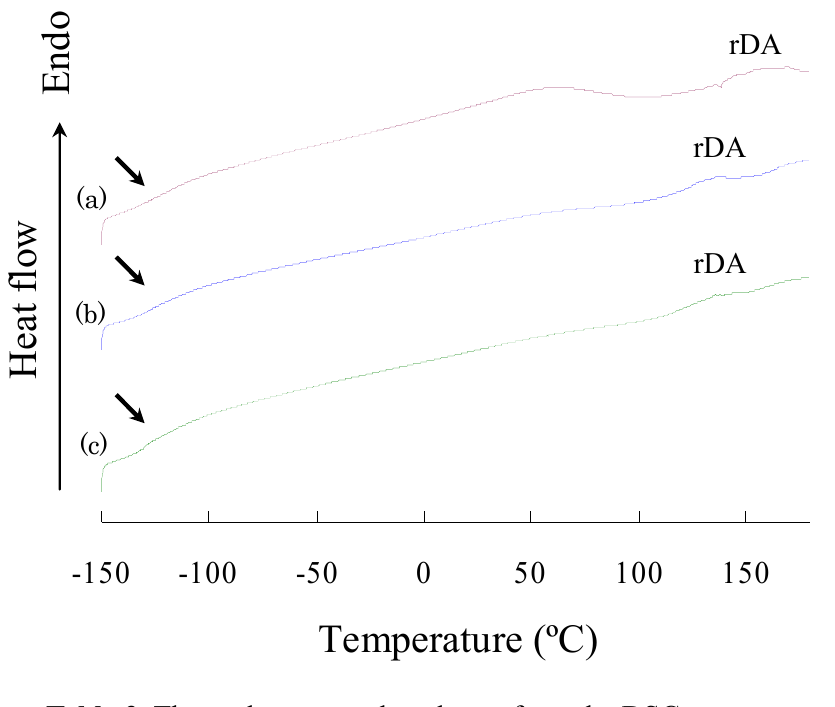
Figure 4. DSC curves of (a) DFT-TMDS-BMI, (b) DFT-DMS20-BMI, and (c) DFT-DMS40-BMI. Arrows indicate the lower glass transition temperatures; and "rDA" indicates the retro-Diels-Alder reaction.